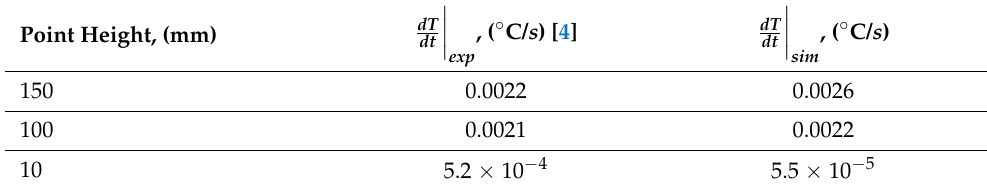
Figure 6. Validation of the present work by comparing temporal variation in temperature at location TT1 [4]. As seen in the above torus image, the graph’s markers reflect the positions of the points in the suppression pool relative to the SCR plane. Table 3. Comparison of experimental and simulated temperature increase rates at different locations.